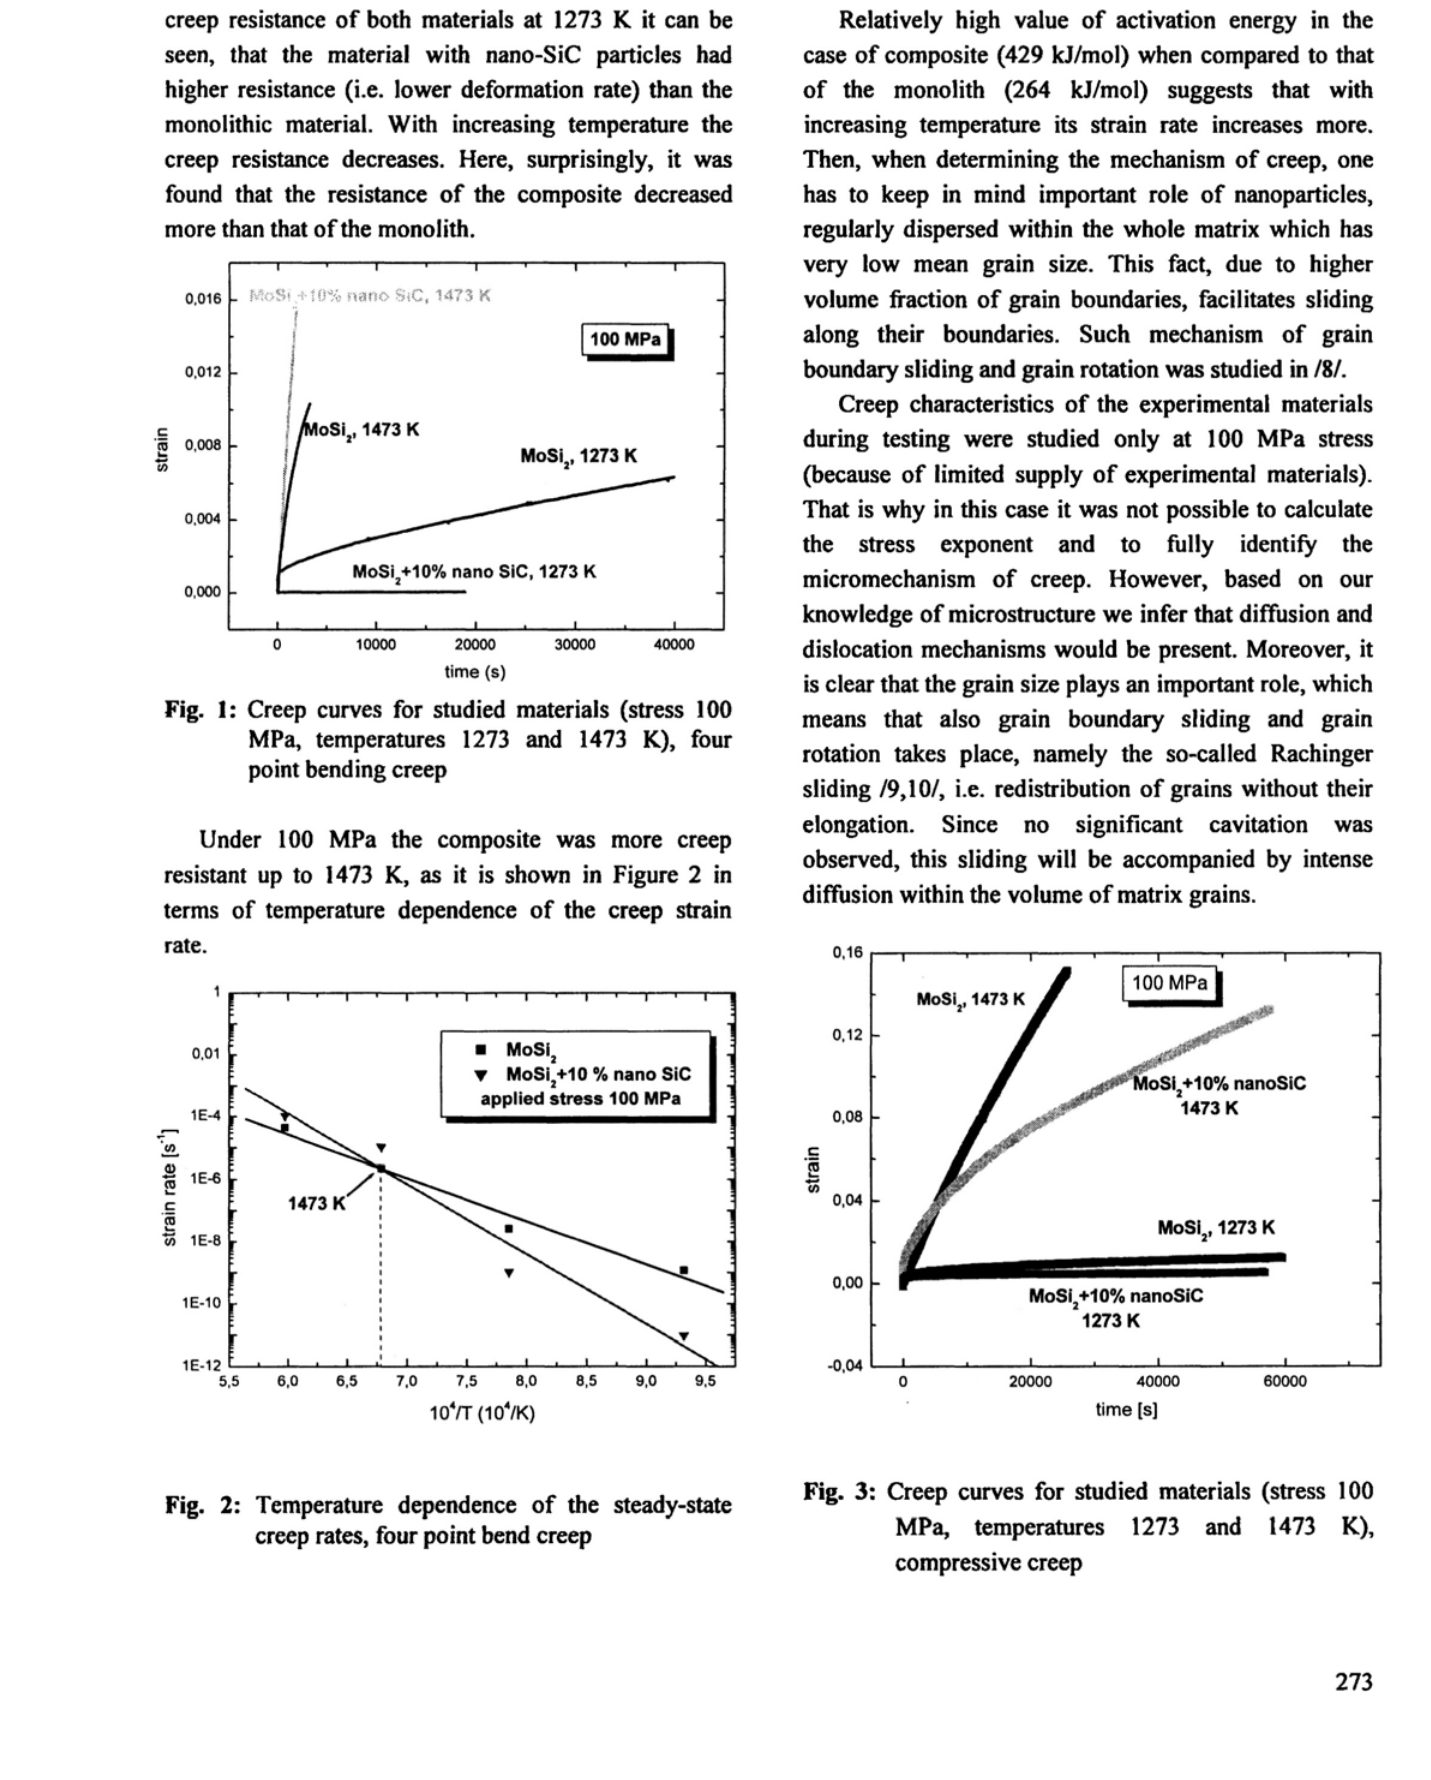
Fig. 2: Temperature dependence of the steady-state creep rates, four point bend creep